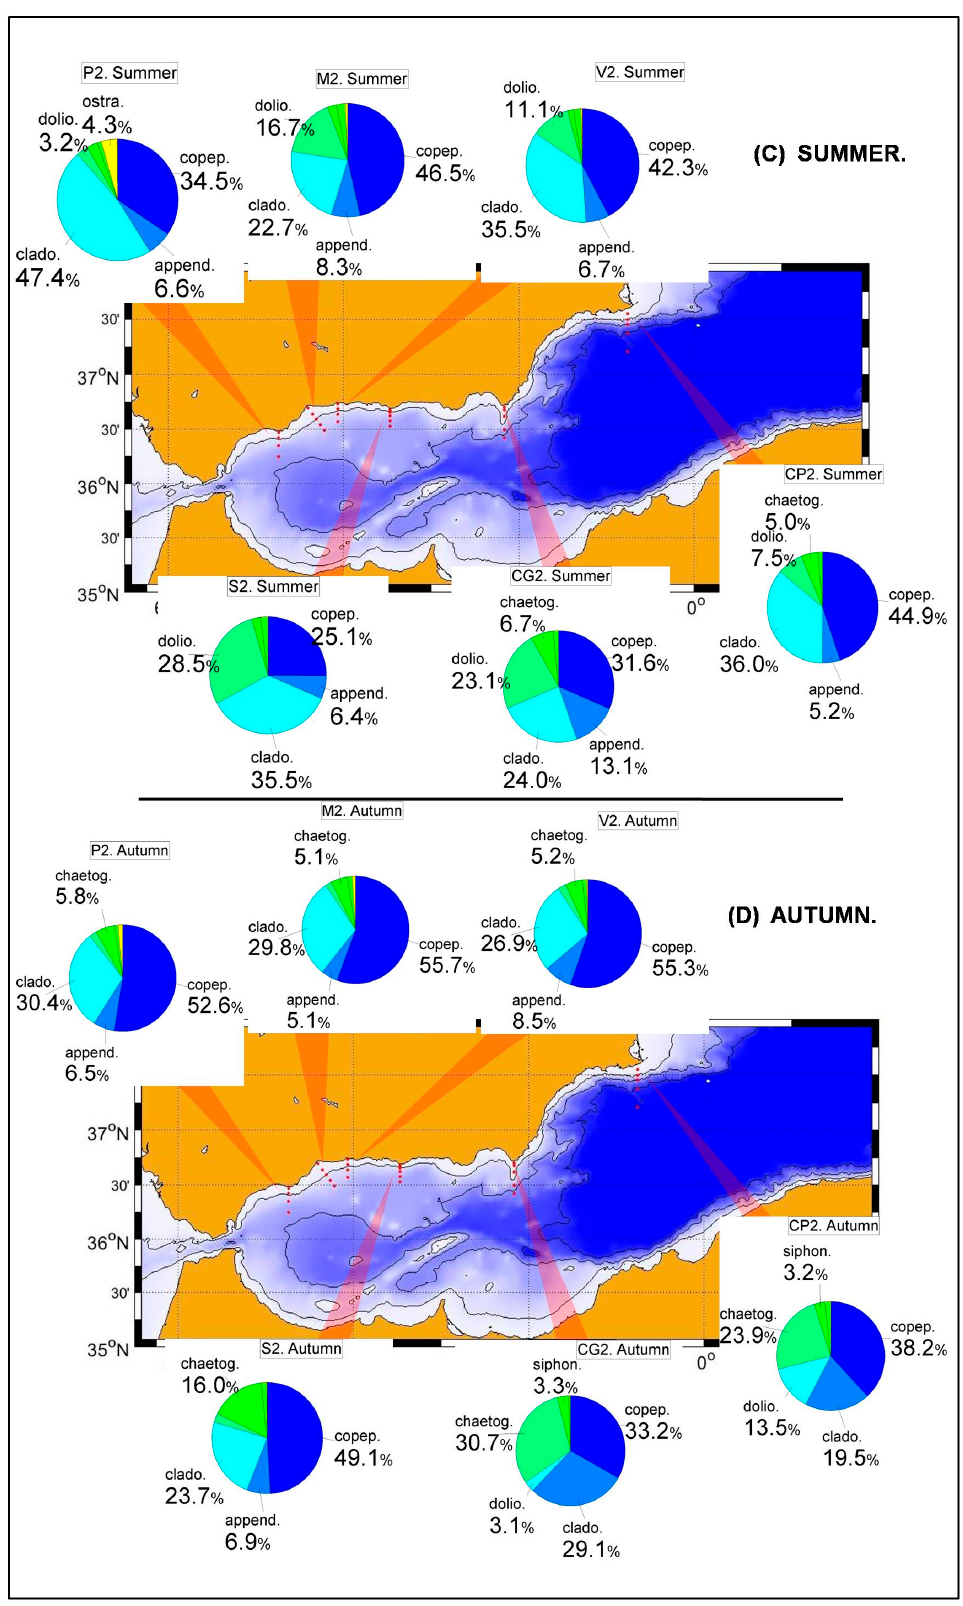
Figure 10. Relative abundances expressed as percentages for broad groups of the meso-zooplankton at the Alboran Sea and Cape Palos. ( A – D ) correspond to winter, spring, summer and autumn respectively.